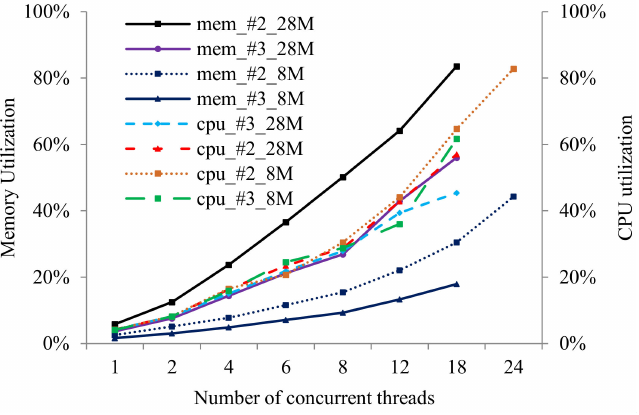
Figure 7. CPU and Memory utilization of